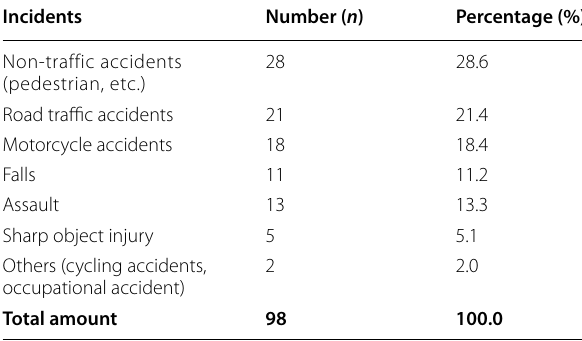
Table 2 Injuries in cases with complaints of post-traumatic olfactory